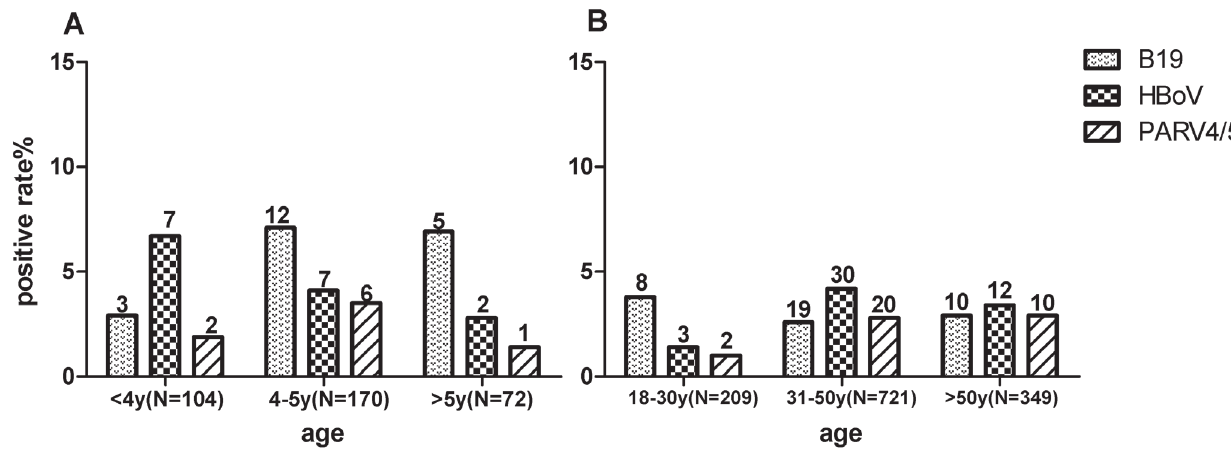
Figure 2. Frequencies of B19, HBoV and PARV4 occurrence in blood samples from different age groups.